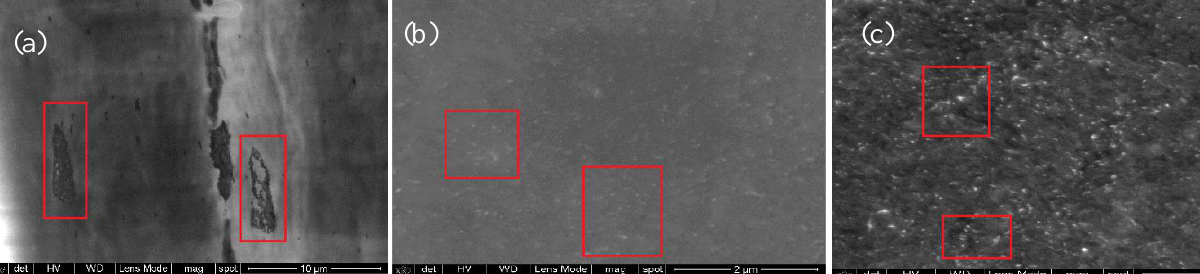
Figure 9. SEM images for samples ( a ) PP-HNT; ( b ) PP-CNT and ( c ) PP-CNTF. Upper images show the morphologies at ×100,000 and lower images in immersion mode taken at